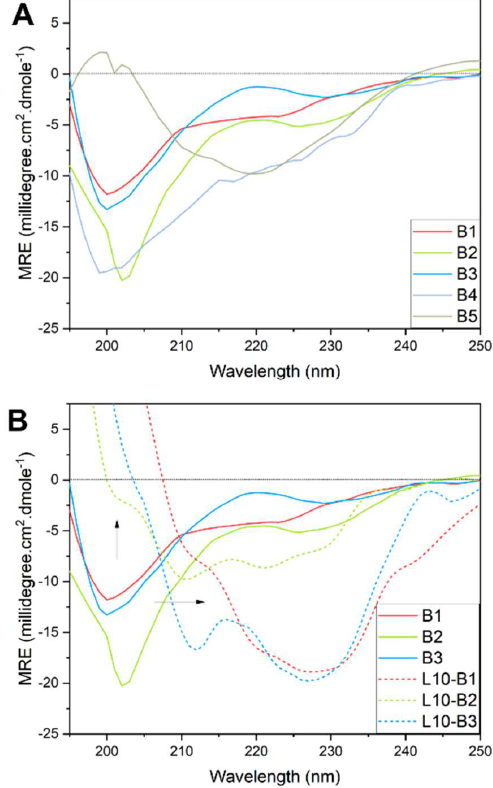
Figure 2. Circular dichroism measurements of the secondary structures of ( A ) the peptide antigens and ( B ) their polyleucine conjugates. The arrows indicate the shift from 197 nm wavelength minima, which denote random coil structure conformation, to higher wavelength minima that show β-sheet and α-helical structures. ( A ) Nonconjugated peptides B1-B4 adopted predominantly a random coil structure conformation 60–70%, with small α-helical contents <30%. B5 peptide adopted predominantly β-sheet conformation (60%), despite that the original peptide sequence in the protein has only 13% β-sheet conformation content (Table S1). ( B ) Conjugation of B1–B3 to polyleucine have dramatically altered secondary structures, compared to native conformation, with increased α-helical content ranging from 60–95%.